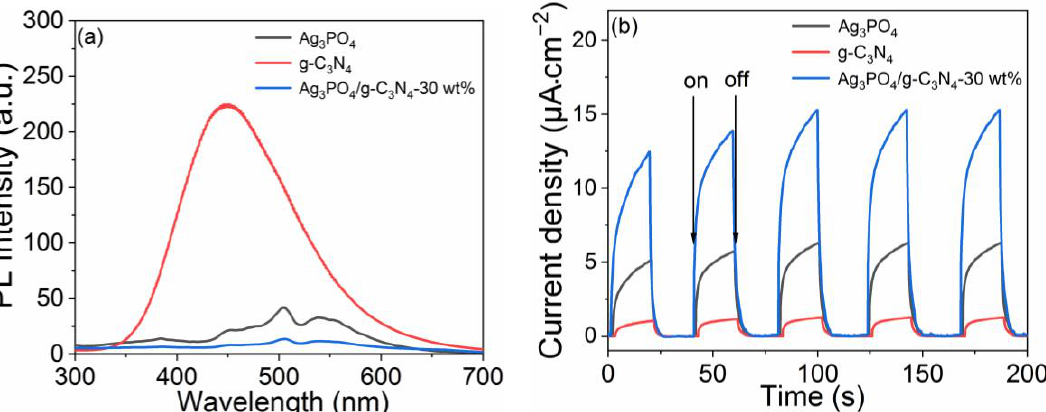
Figure 4. ( a ) Photoluminescence spectra and ( b ) transient photocurrent response curves of Ag 3 PO 4 , g-C 3 N 4 , and Ag 3 PO 4 /g- C 3 N 4 -30wt%.